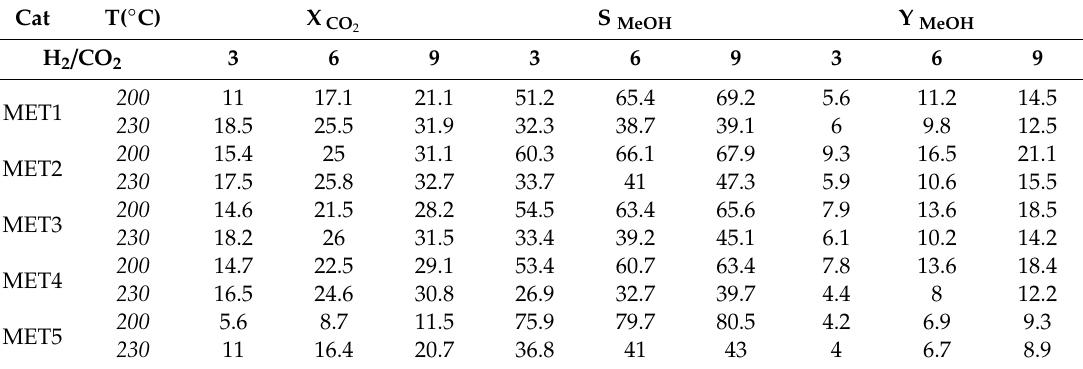
Table 3. Comparative analysis of the selected catalysts under improved operating conditions (GHSV = 200 h − 1